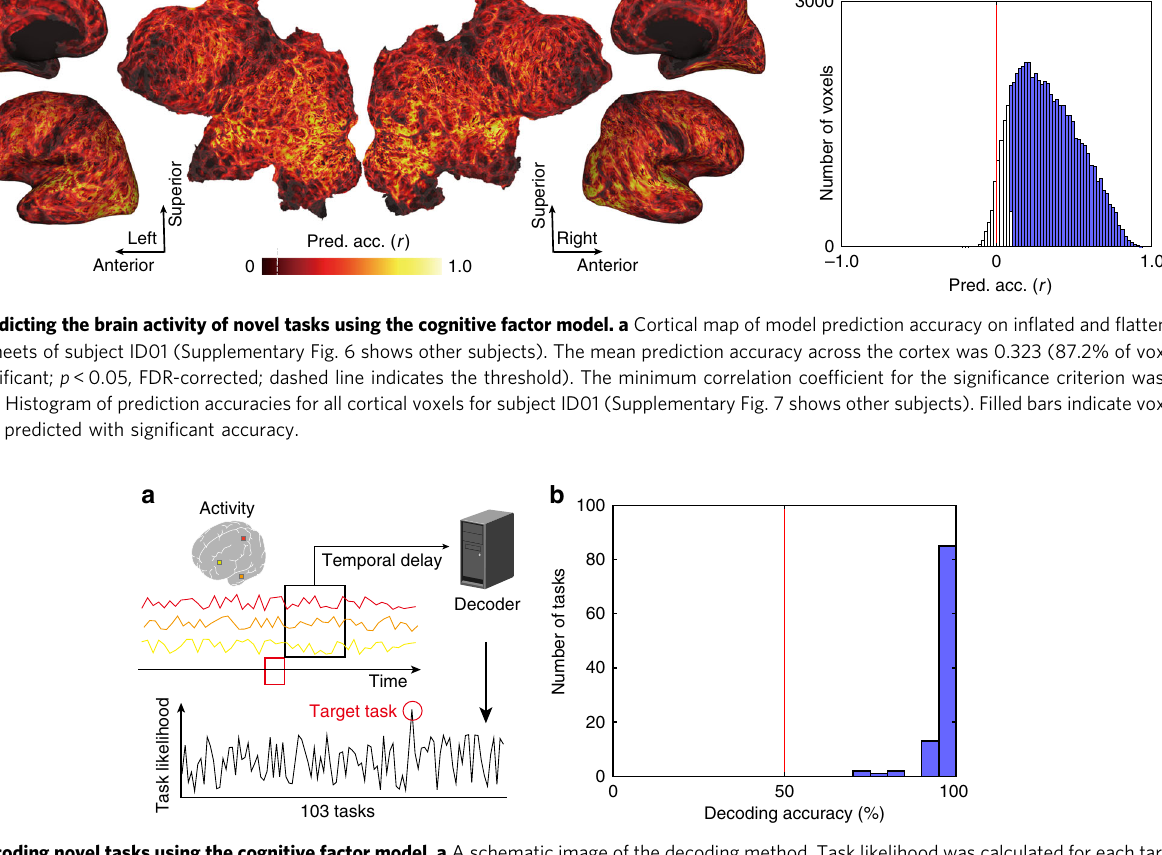
Fig. 6 Decoding novel tasks using the cognitive factor model. a A schematic image of the decoding method. Task likelihood was calculated for each target time point using brain activity with hemodynamic temporal delays. The decoding accuracy was examined by a series of binary classi fi cations between the target task (red circle) and the other remaining tasks. b Histogram of task decoding accuracies for all tasks for subject ID01 using a binary classi fi cation (Supplementary Fig. 9 shows the other subjects). The red line indicates the chance-level accuracy (50%). Filled bars indicate tasks that were decoded with signi fi cant accuracy (mean decoding accuracy, 96.8%; all tasks were signi fi cant; one-sided sign test, p < 0.05,